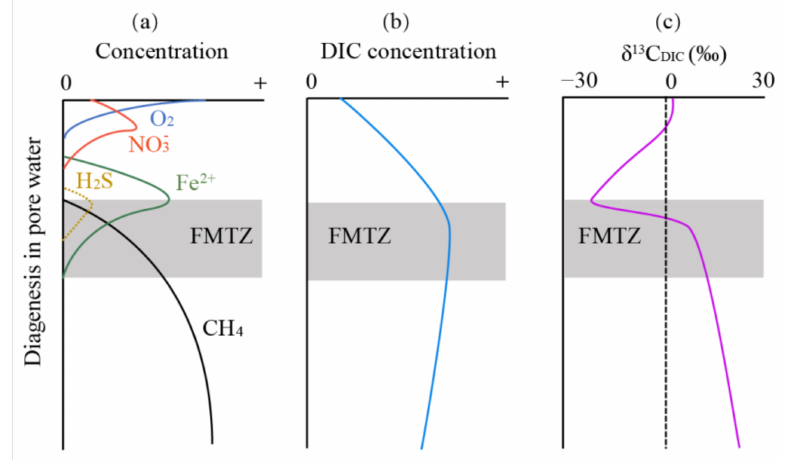
Figure 8. Schematic model of the early-diagenesis ( a ) and ferric-methane transition zone (FMTZ) controlled concentrations of dissolved inorganic carbon (( b ), DIC) and carbon isotopic composition of DIC (( c ), δ 13 C DIC ) in the pore water. Oxygen (O 2 ) and nitrate (NO 3 − ) curves in ( a ) represent the aerobic respiration and nitrate reduction before dissimilatory iron reduction [45]. The dotted line of hydrogen sulfide (H 2 S) represents that free H 2 S might not exist in a sulfate-poor environment but be quickly combined with Fe 2+ to form sulfide. The FMTZ occurs due to a lack of sulfate in pore water which impairs the sulfate reduction reaction and thus does not inhibit methanogenesis. The 13 C-enriched CO δ 13 C 2 generated through methanogenesis significantly increases the DIC value in the pore water ( c ) and makes an alkaline environment conducive to dolomite/ankerite precipitation and then decreases the DIC’s concentration in the pore water ( b